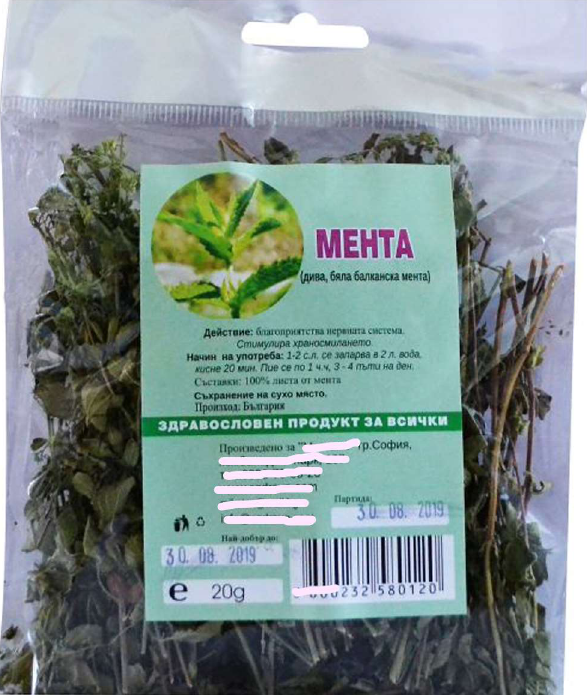
Figure 10 . Micromeria dalmatica , the most often mentioned species for most applications according to Σ U in Central Rhodopes .